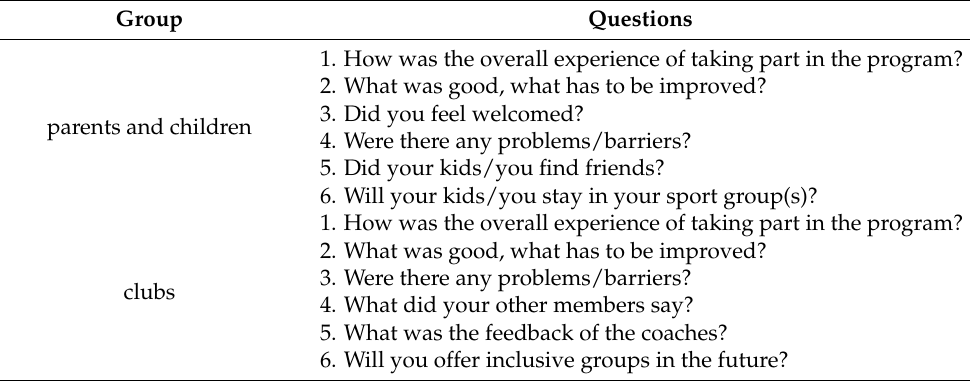
Table 3. Interview questions for qualitative program evaluation, divided by interview groups at t2.